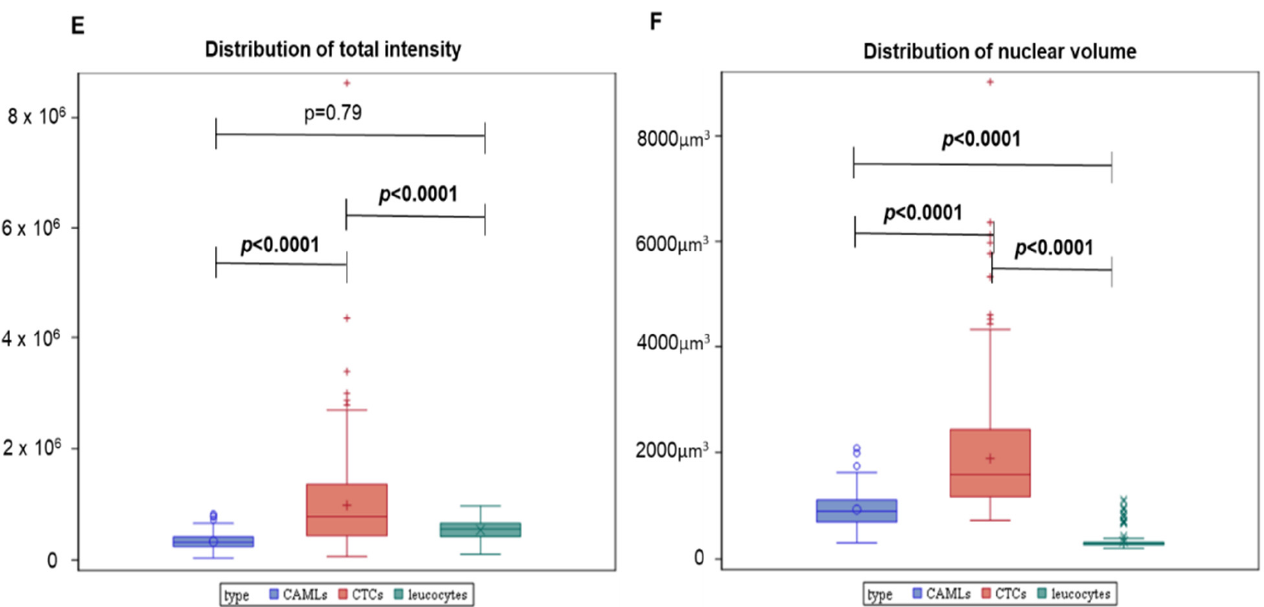
Figure 4. Differences in telomere parameters between CTCs, normal leucocytes, and CAMLs. ( A ) Total number of telomere signals—a sum value representing the number of telomeres found in each cell population. ( B ) Total number of telomere aggregates—telomeres in close proximity forming clusters that cannot be further resolved at an optical resolution limit of 200 nm. Functionally, telomeric aggregates are fused telomeric signals or telomeres in close illegitimate proximity able to engage in recombination events. ( C ) The a / c ratio (nuclear spatial distribution of telomeres). The a/c ratio is defined as the nuclear space occupied by telomeres, represented by three axes of length a, b , and c . The ratio between a and c axes, a / c ratio, reflects the distribution of telomeres, which changes at different stages of the cell cycle. A higher a / c ratio indicates cells in G2 and/or G2/M phase, while lower a / c ratio represents cells in G0/G1 and/or S phase. ( D ) Total telomere signal intensity. ( E ) Average intensity (proportional to telomere length. For total intensity and average intensity, the position of each telomere is identified by using a threshold. Then, the center of gravity and the integrated intensity of each telomere is calculated as arbitrary units based on the number of sequences CCCTAA/probe intensity. The integrated intensity of each telomere is the appropriate parameter for determining the length of the telomere. ( F ) Nuclear Volume. The x-axis assigns one box for each cell population analyzed (results of all analyzed cells). The y-axis refers to the lower value, first quartile, average (mean), median, and third